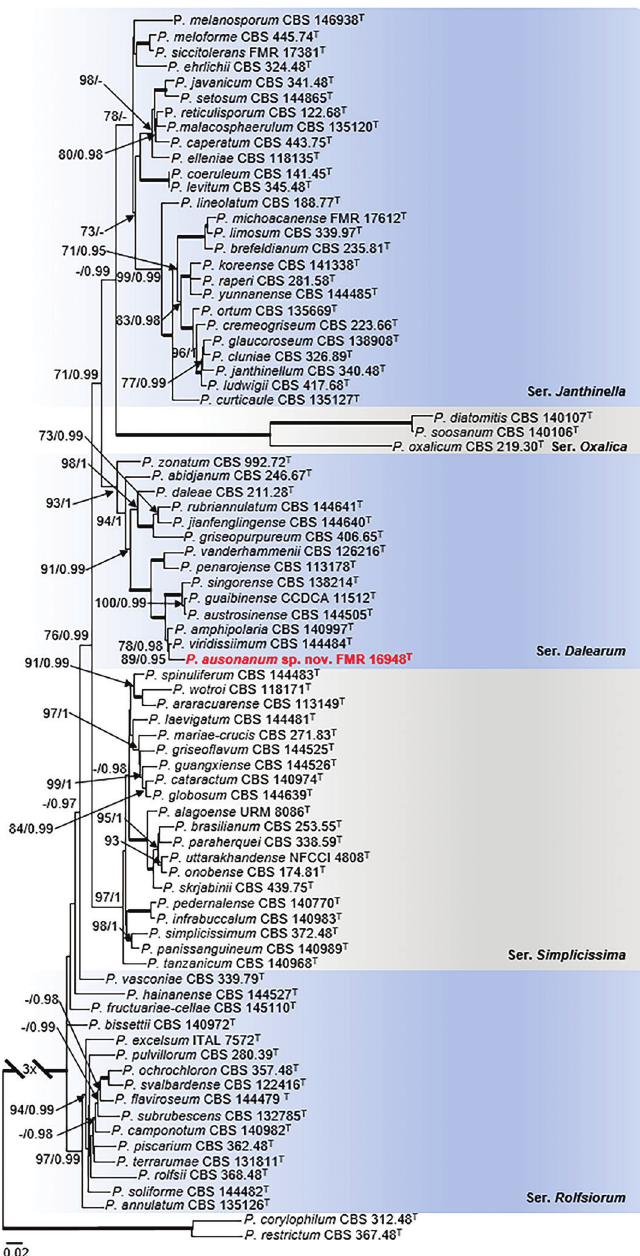
Figure 6. Phylogenetic tree of Penicillium section Lanata-Divaricata based on ML analysis obtained by RAxML inferred from the combined tub 2, cmdA , ITS, and rpb 2 loci. Branch lengths are proportional to phy- logenetic distance. Bootstrap support values/Bayesian posterior probability scores above 70%/0.95 are indi- cated on the nodes. Bold branches indicate bs/pp values 100/1. The tree is rooted to P. restrictum CBS 367.48 and P. corylophilum CBS 312.48. The name in red is the new species described in this study. T = Ex-type